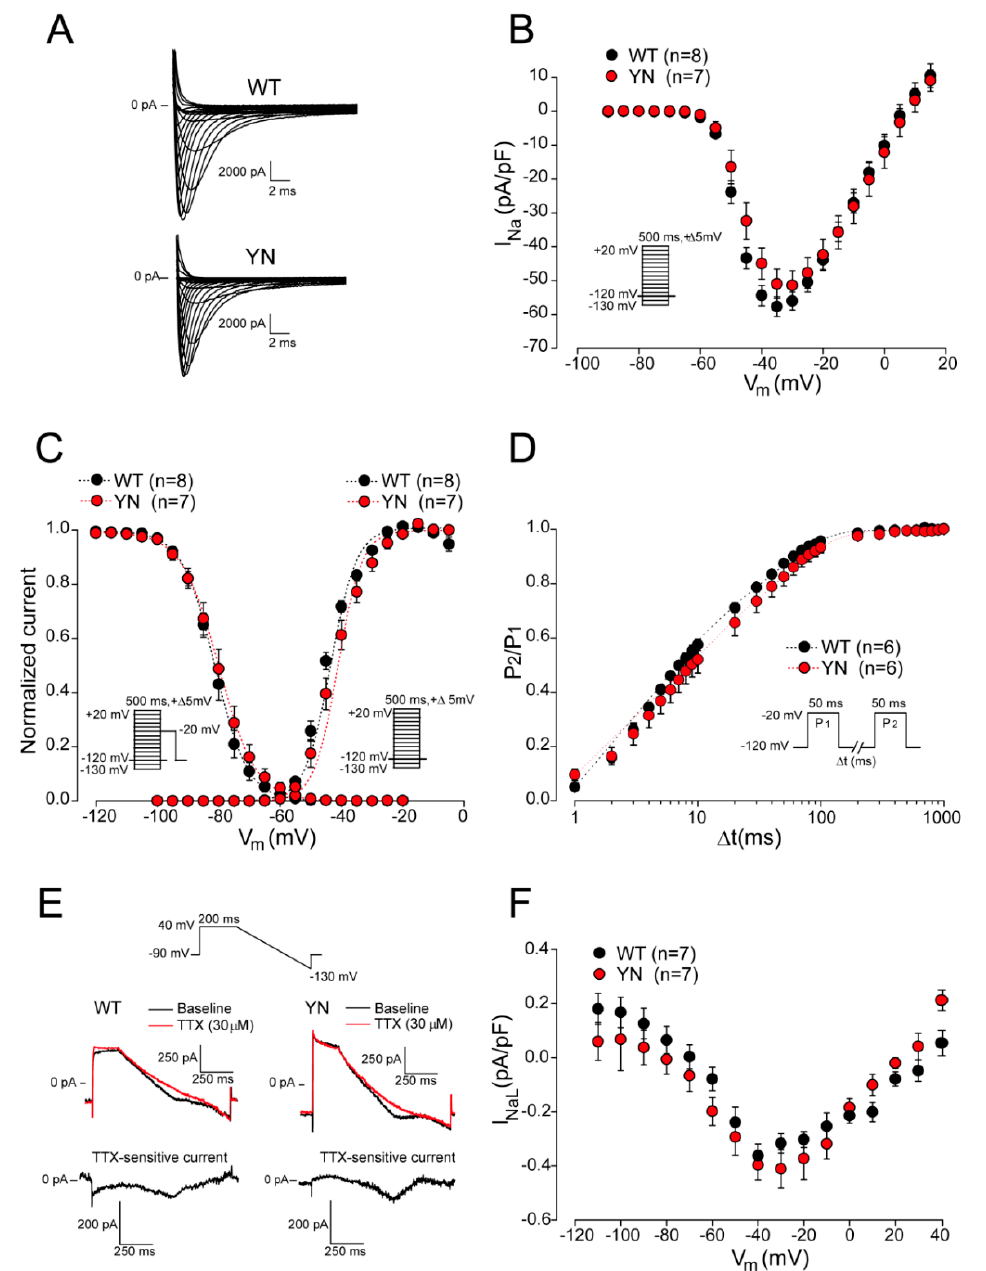
Figure 6. Sodium current properties in wild-type and Scn5a -p.Y1981N cardiomyocytes. ( A ) Representative example of sodium current (I Na ) traces recorded in wild-type (WT) and in Scn5a -p.Y1981N (YN) cardiomyocytes during a 5-mV ascending voltage step protocol. ( B ) Average I Na -voltage relationship ( n = 8 cardiomyocytes from six WT mice and n = 7 cardiomyocytes from four YN mice), ( C ) voltage dependence of activation and inactivation ( n = 8 cardiomyocytes from six WT mice and n = 7 from four YN mice) and ( D ) time course of recovery from inactivation ( n = 6 cardiomyocytes from four WT mice and n = 6 cardiomyocytes from four YN mice) for WT and YN cardiomyocytes. Insets: voltage clamp protocols. ( E ) Typical late sodium current (I NaL ) traces recorded using a descending ramp protocol (upper panel) in WT and YN cardiomyocytes before (baseline) and after application of 30 µ M tetrodotoxin (TTX). TTX-sensitive currents were obtained by subtraction of the current measured in the presence of TTX from the current measured earlier in the absence of TTX. ( F ) Average I NaL -voltage relationship for WT ( n = 7 cardiomyocytes from four mice) and YN cardiomyocytes ( n = 6 from five mice).